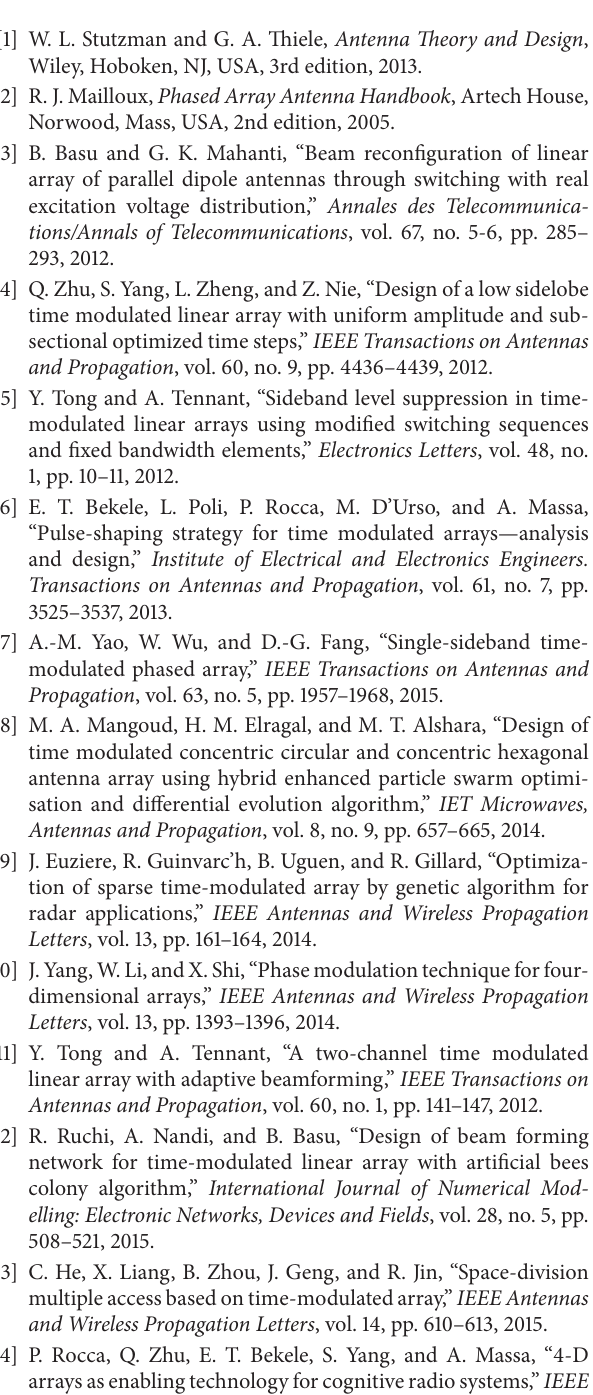
Table 3: Desired and obtained